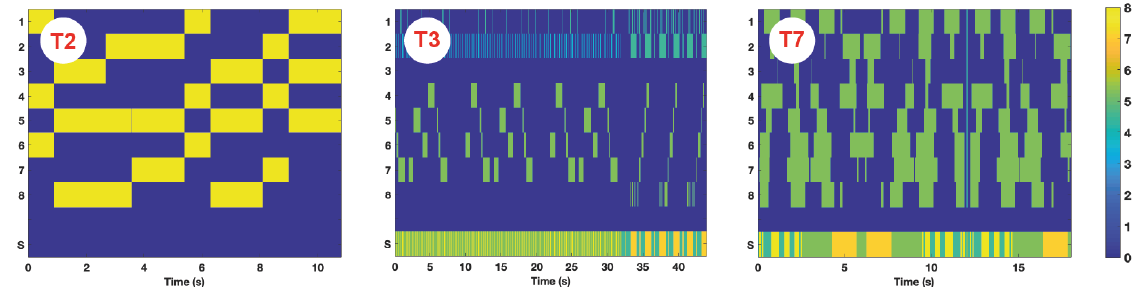
Figure A2. The tactile mappings T2 (Minor chord progression), T3 (Ashes to Ashes) and T7 (randomised pattern). Intensity is shown by hue, motors 1–8 are the vibration motors along the forearm, S is the squeezer on the upper